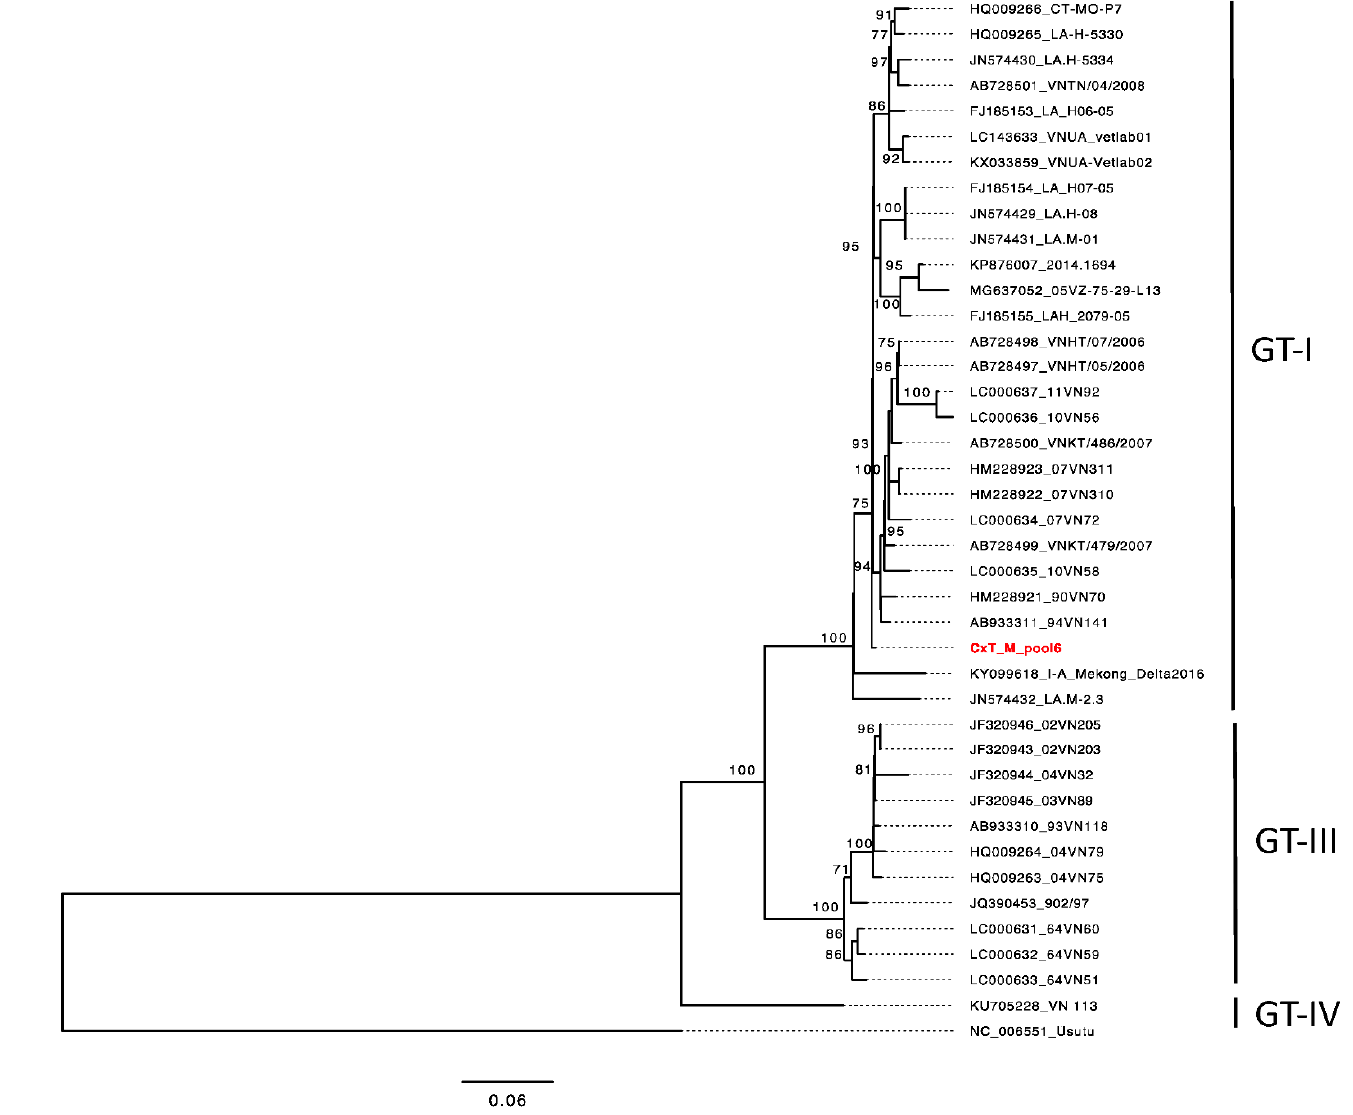
Figure 2. Phylogenetic tree of JEV. The tree was constructed via the maximum-likelihood method implemented in the IQ tree server, using the best fit GTR + G + r substitution model. The ultrafast bootstrap values > 75 are shown on the branches. The tree was rooted on Usutu virus Vienna 2001 strain (GenBank accession no. NC_006551.1). The scale bar shows the nucleotide substitutions per site. The highlight taxa in the tree show the JEV sequences recovered from 385 pools in this study. Genotypes (GTs) I–IV are shown to the right.